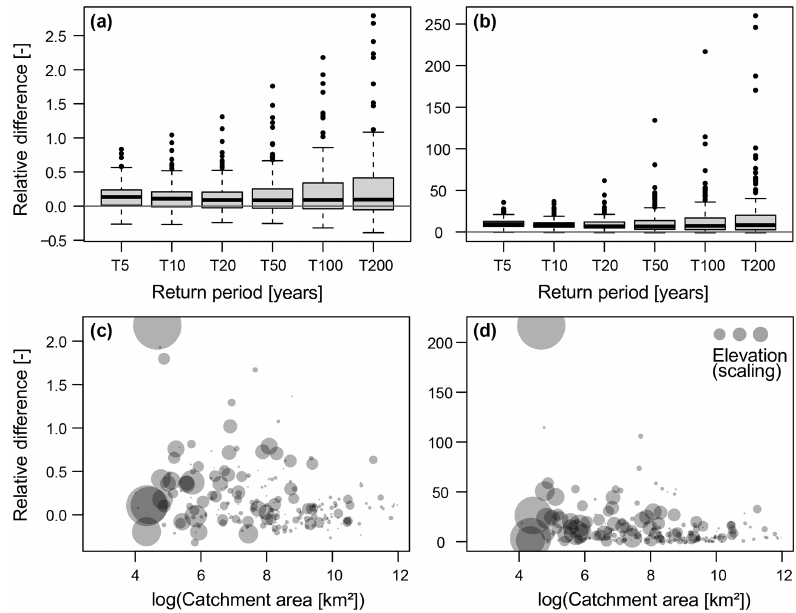
Figure 9. Relative difference between the observed and simulated ((obs-sim)/sim) (a) best estimates and (b) the range of uncertainty bounds ( Q 95 − Q 05 ) for different return periods (5, 10, 20, 50, 100, and 200 years) across catchments (one point in the box plot corre- sponds to one catchment). Relative difference between the observed and simulated ((obs-sim)/sim) (c) best estimates and (d) the range of uncertainty bounds ( Q 95 − Q 05 ) for the 100-year return period in relation to catchment area and elevation. The larger the dot, the higher elevation of a catchment.